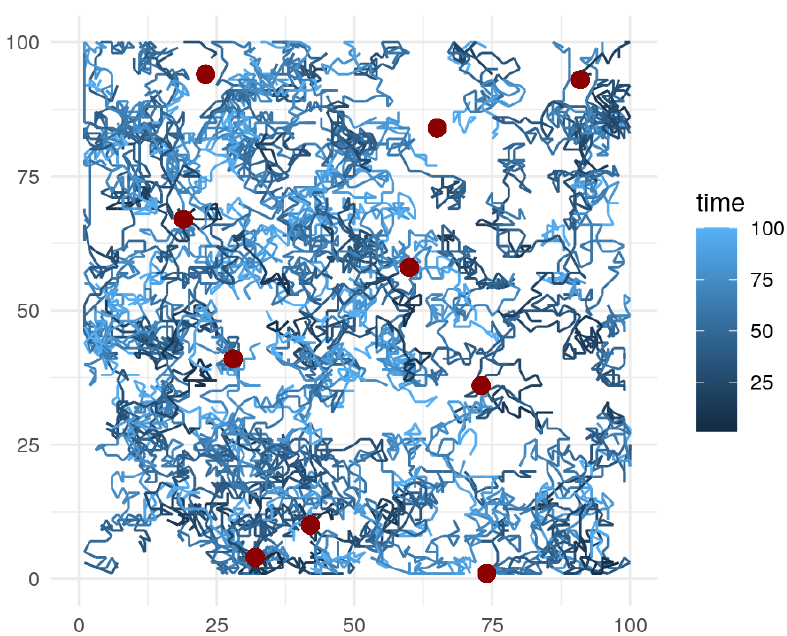
Figure 5. Simulated sensor trajectories. We marked 250 mobile sensor trajectories in blue, with the shade implying the time step. Fixed sensors marked in dark